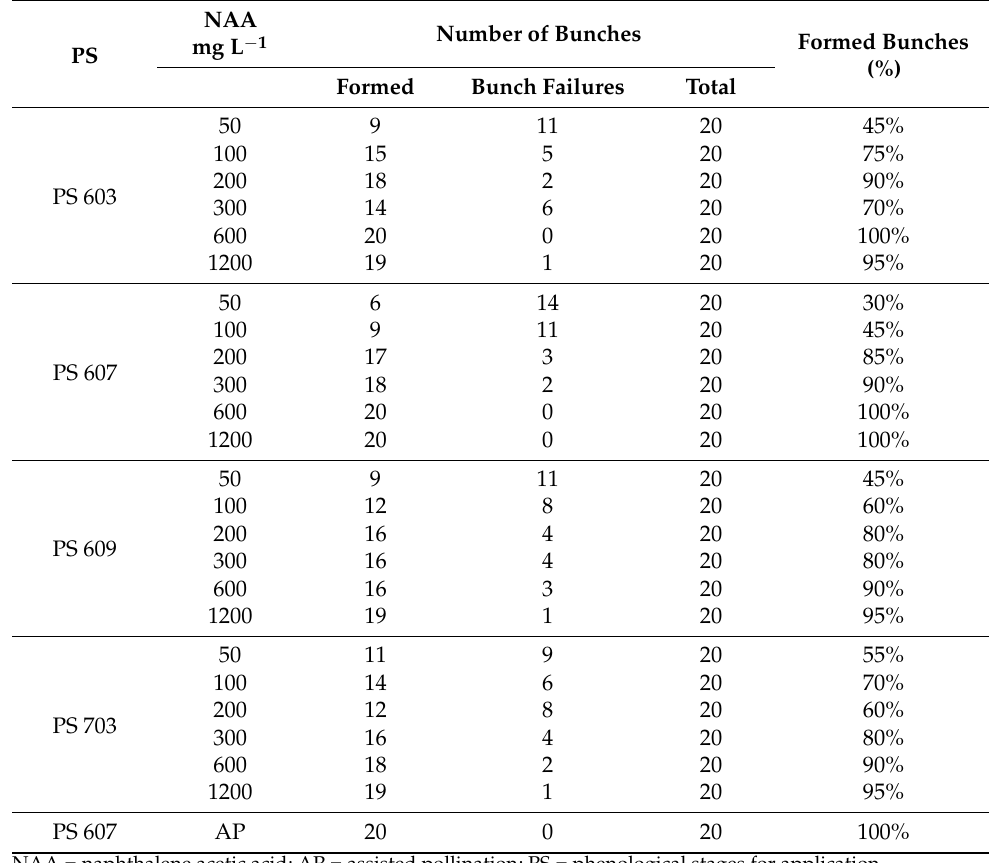
Table 3. Effect of single NAA applications on the proportion of bunches formed. Different NAA con- centrations were applied to female inflorescences at four phenological stages to induce parthenocarpy in the OxG hybrids (Coari x La M é ).